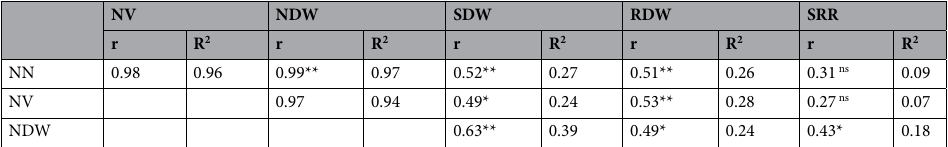
Table 10. Correlation between traits of nodulation and dry matter yield. **Highly significant; * Significant; ns Not significant; NN nodule numbers plant −1 , NV nodule volume (mg) plant −1 , SDW shoot dry weight (g) plant −1 , RDW root dry weight (g) plant −1 , SRR shoot to root